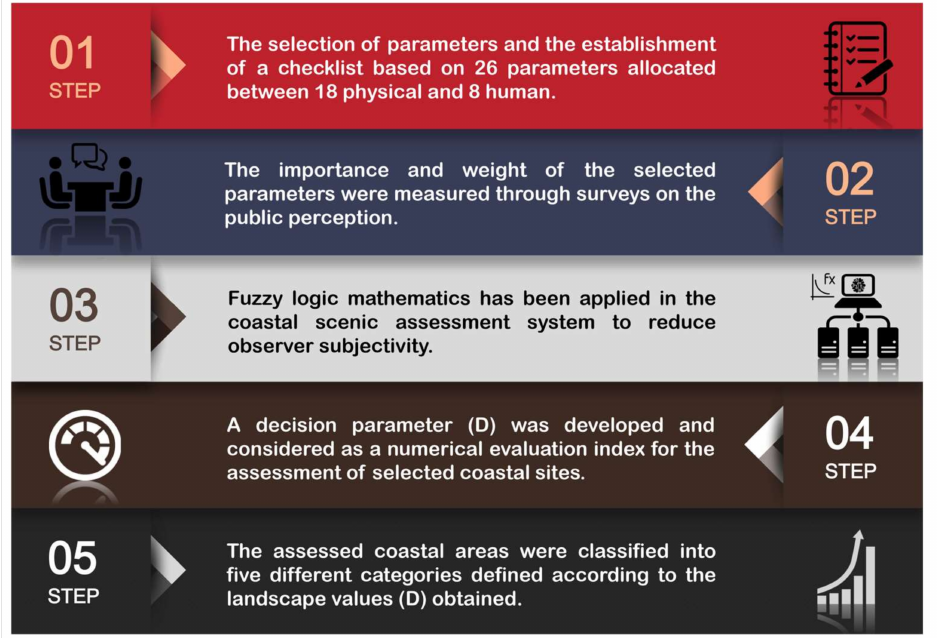
Figure 2. Schematic representation of the main steps of the methodology used